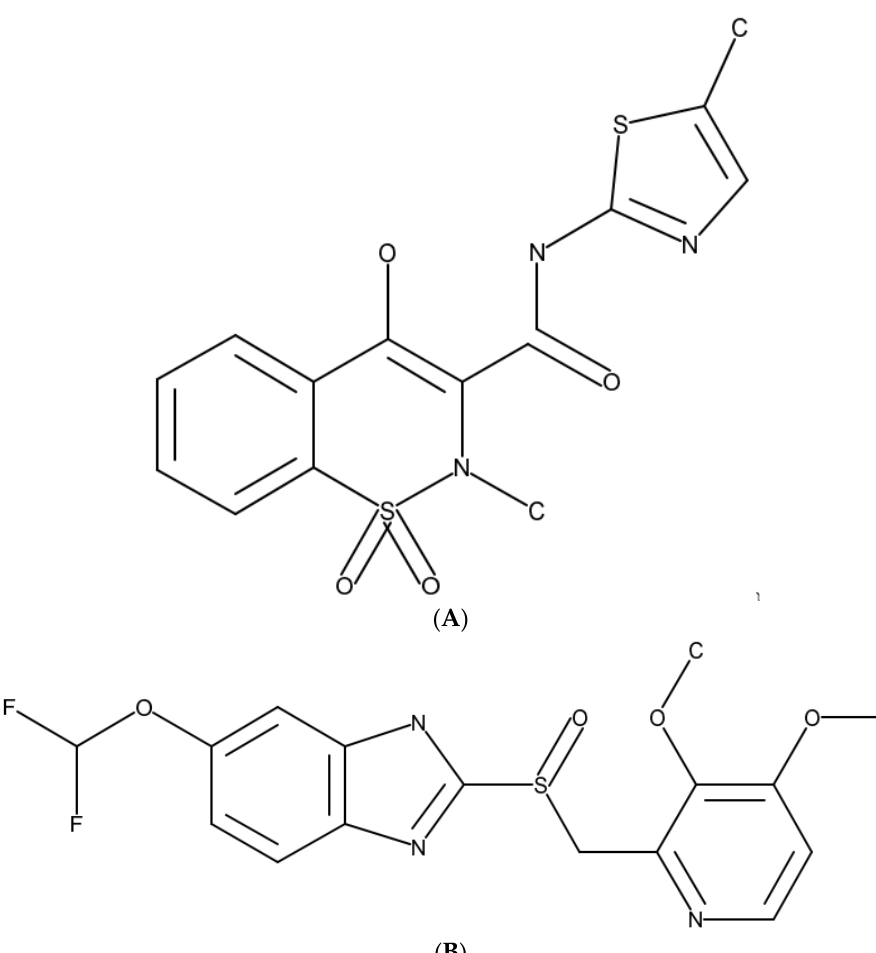
Figure 1. ( A ) Chemical structure of meloxicam. ( B ) Chemical structure of pantoprazole.